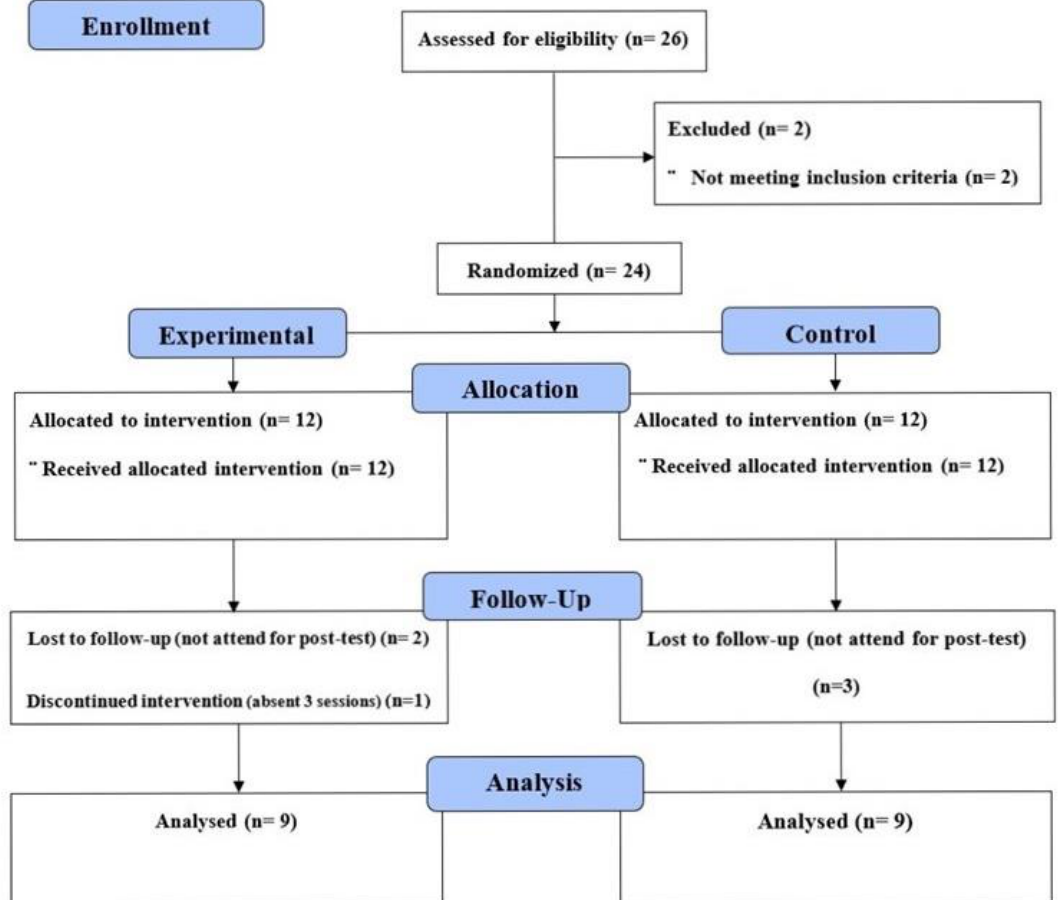
Figure 1. Consort diagram of participants ’ flow.